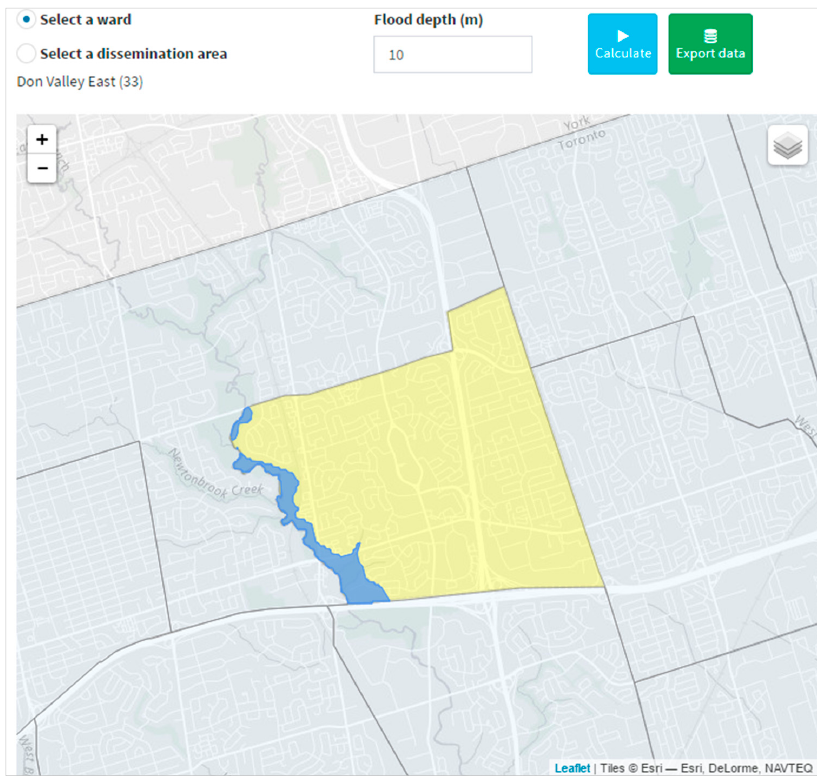
Figure 1. Sample of flood inundation within the ResilSIM tool.